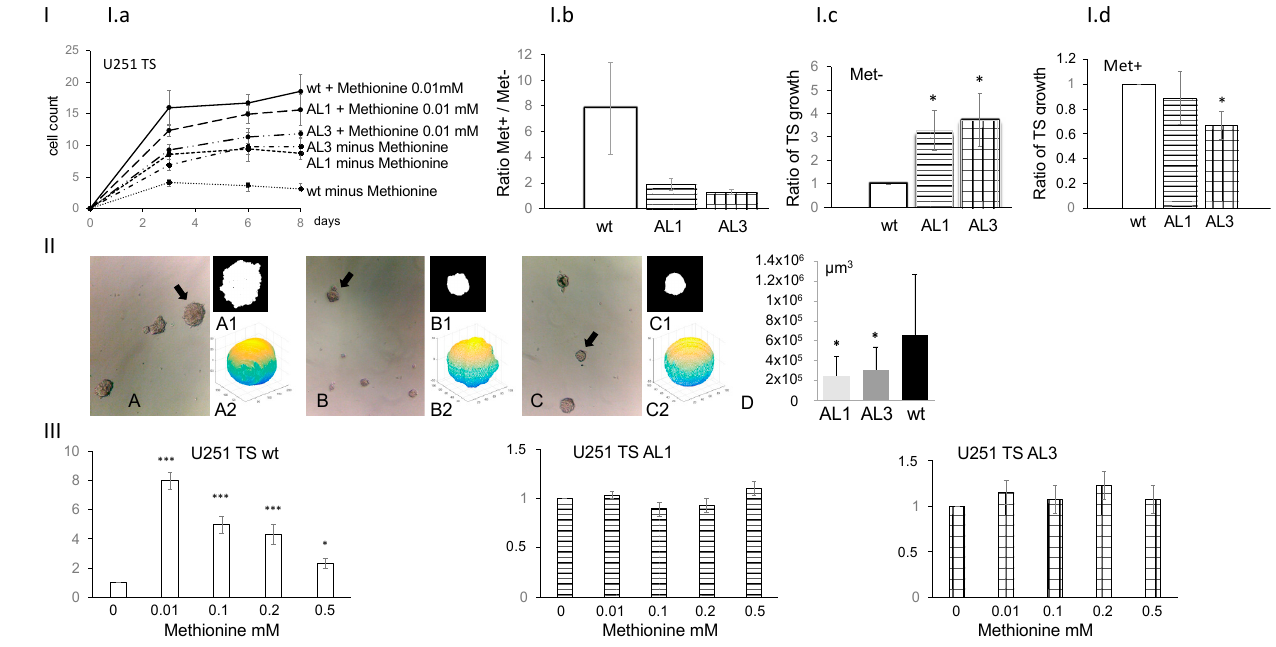
Figure 2. Tumor spheres (TS) derived from U251 ALDH1L2 KO cells display not only decreased growth but also methionine-independent growth. TS growth in methionine free (MET − ) vs. methionine (0.01 mM)-containing (MET+) media were compared between KO vs. wt cells. In ( Ia ), in MET − , TS of the KO cells grew better than that of the wt. In ( Ib ), the TS growth ratio was calculated as TS growth in MET+) divided by that in MET − . The higher the ratio, the more the methionine growth dependency. In ( Ic ), TS growth in MET − was normalized to that of the wt TS in MET − . In ( Id ), TS growth in MET+ was normalized to that of the wt TS MET+. In ( II ), analyses of the computer-assisted reconstruction of sphere volumes revealed that ALDH1L2 KO has smaller “tumor sphere volume”. A, A1, A2 = wt cells. B, B1, B2 = AL1 cells. C, C1, C2 = AL3 cells. A1, B1, C1 are results of segmentation. A2, B2, C2 are results of 3D reconstructions: axes values are in pixels, and images are not to scale, so size differences can be appreciated visually in A1, B1, C1 but are best demonstrated by measured volumes: A = 1,857,000 µ m 3 , B = 258,000 µ m 3 , C = 206,000 µ m 3 . D: Spheroid volumes versus wt ( µ m 3 ), mean ± SD, * p < 0.003, *** p < 0.001, Student t -test. In ( III ), ALDH1L2 KO suppressed U251 TS growth methionine dependency. For each cell type, mean ± SE of three independent experiments (each done in quadruplicate) is shown (three biological replicates each include four technical replicates). wt: wild type, AL1: U251 cells ALDH1L2 exon 1 KO, AL3: U251 cells ALDH1L2 exon 3